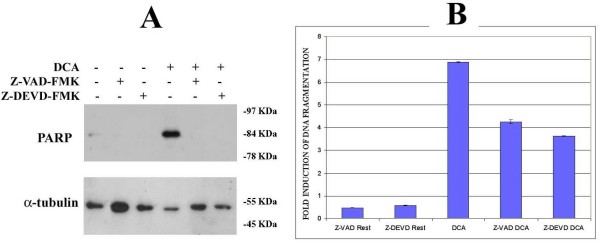
DCA-Induced PARP cleavage and DNA fragmentation is Caspase Dependent. SKGT4 cells were treated with 50 μM Z-VAD-FMK or 50 μM Z-DEVD-FMK for 1 hr prior to the addition of 400 μM DCA for 6 hr. Whole cell lysates were standardized to 50 μg as described in experimental procedures. PARP cleavage was assessed by immunoblotting with an anti-PARP antibody followed by anti-α-tubulin as loading control (A). DNA fragmentation was assessed by ELISA (B). Results are given as fold induction of DNA fragmentation relative to unstimulated cells. Mean ± SD. Results are representative of at least two independent experiments.